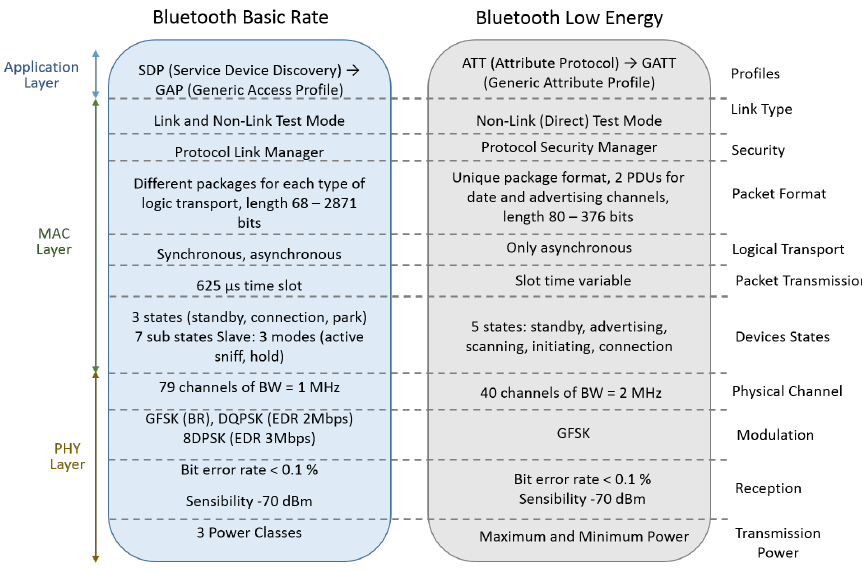
Figure 9. Bluetooth basic rate versus Bluetooth low